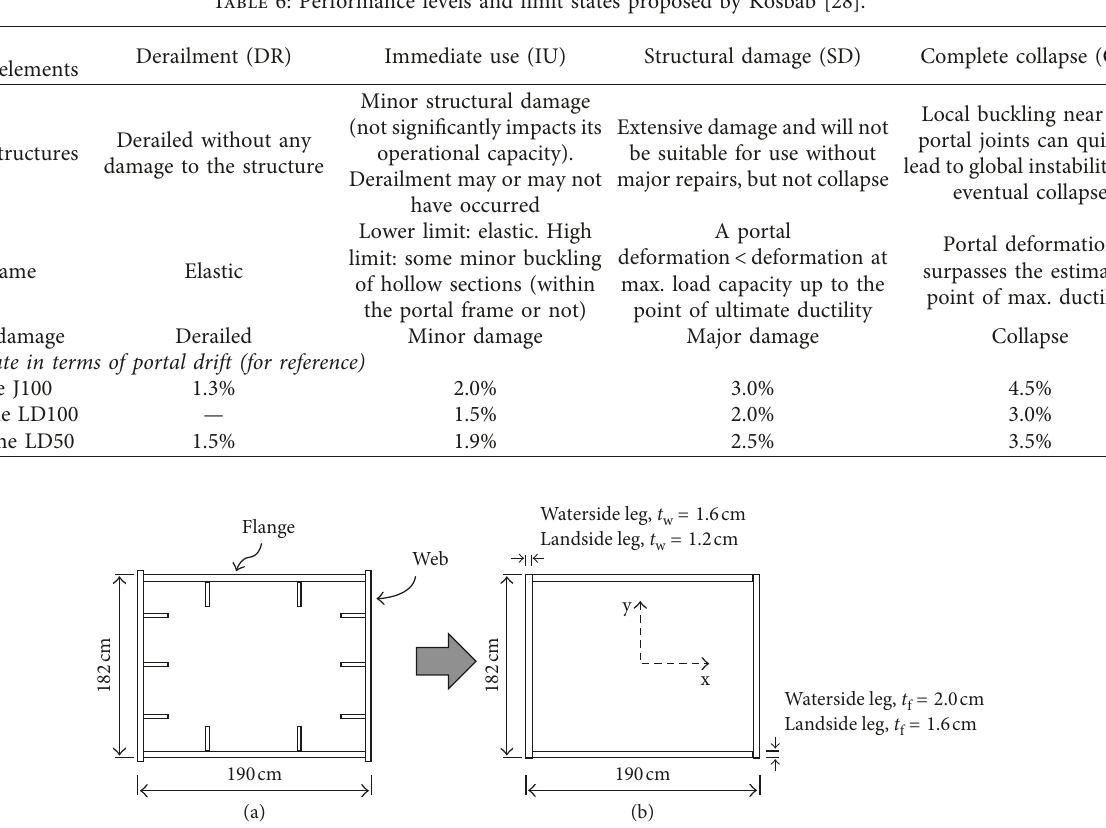
Damage to toe (including pull-out of vehicle, fracture of anchor/brakes) Note . μ and ε max are the ductility factor and strain limit for the structure, respectively. Table 6: Performance levels and limit states proposed by Kosbab [28].